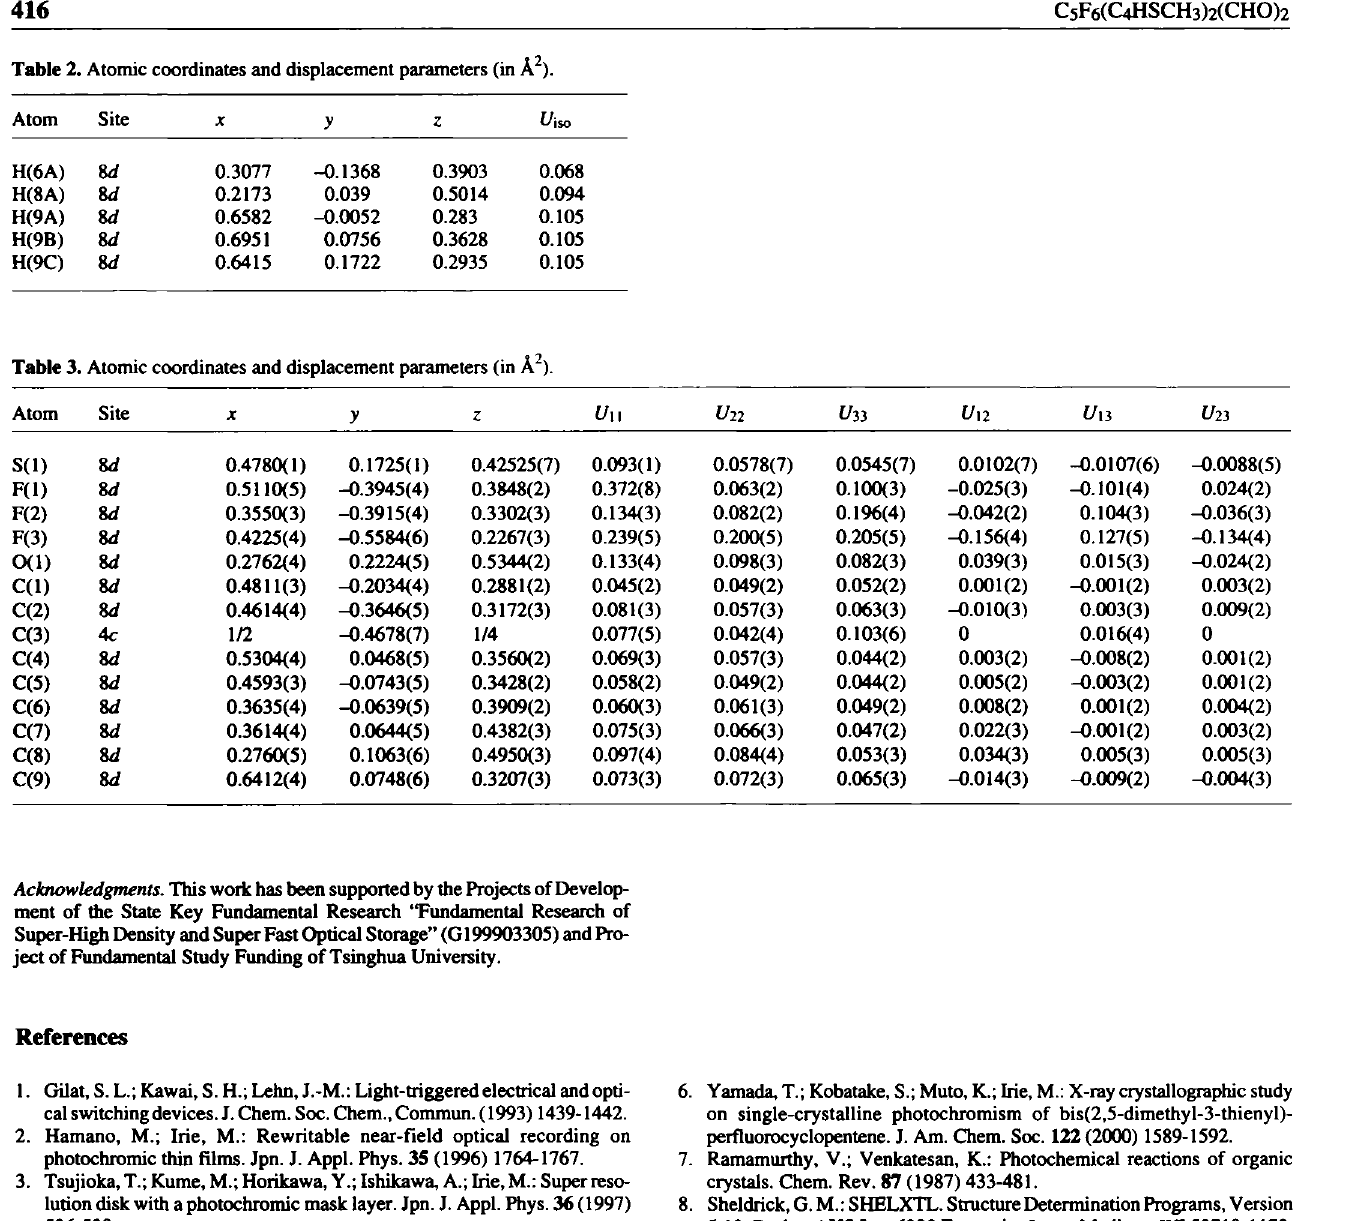
Table 3. Atomic coordinates and displacement parameters (in Â 2